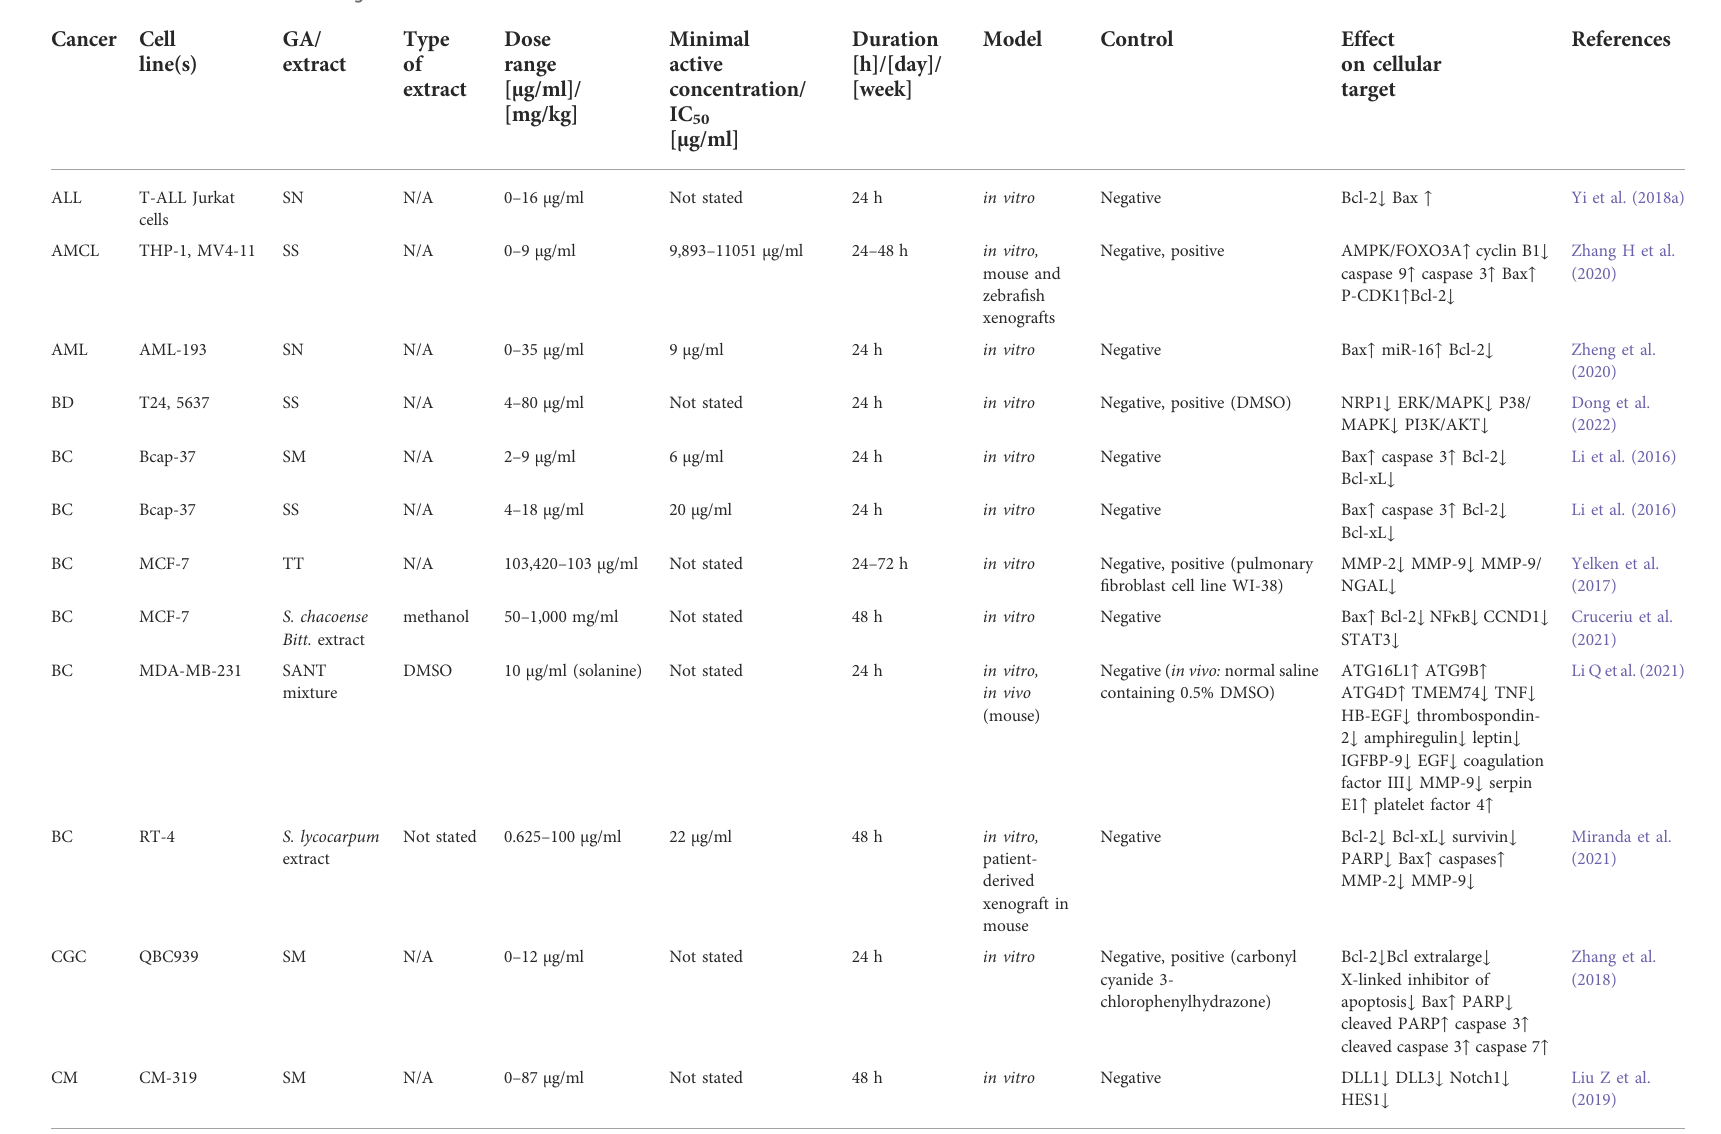
TABLE 1 Effect of GAs on cellular targets in cancer